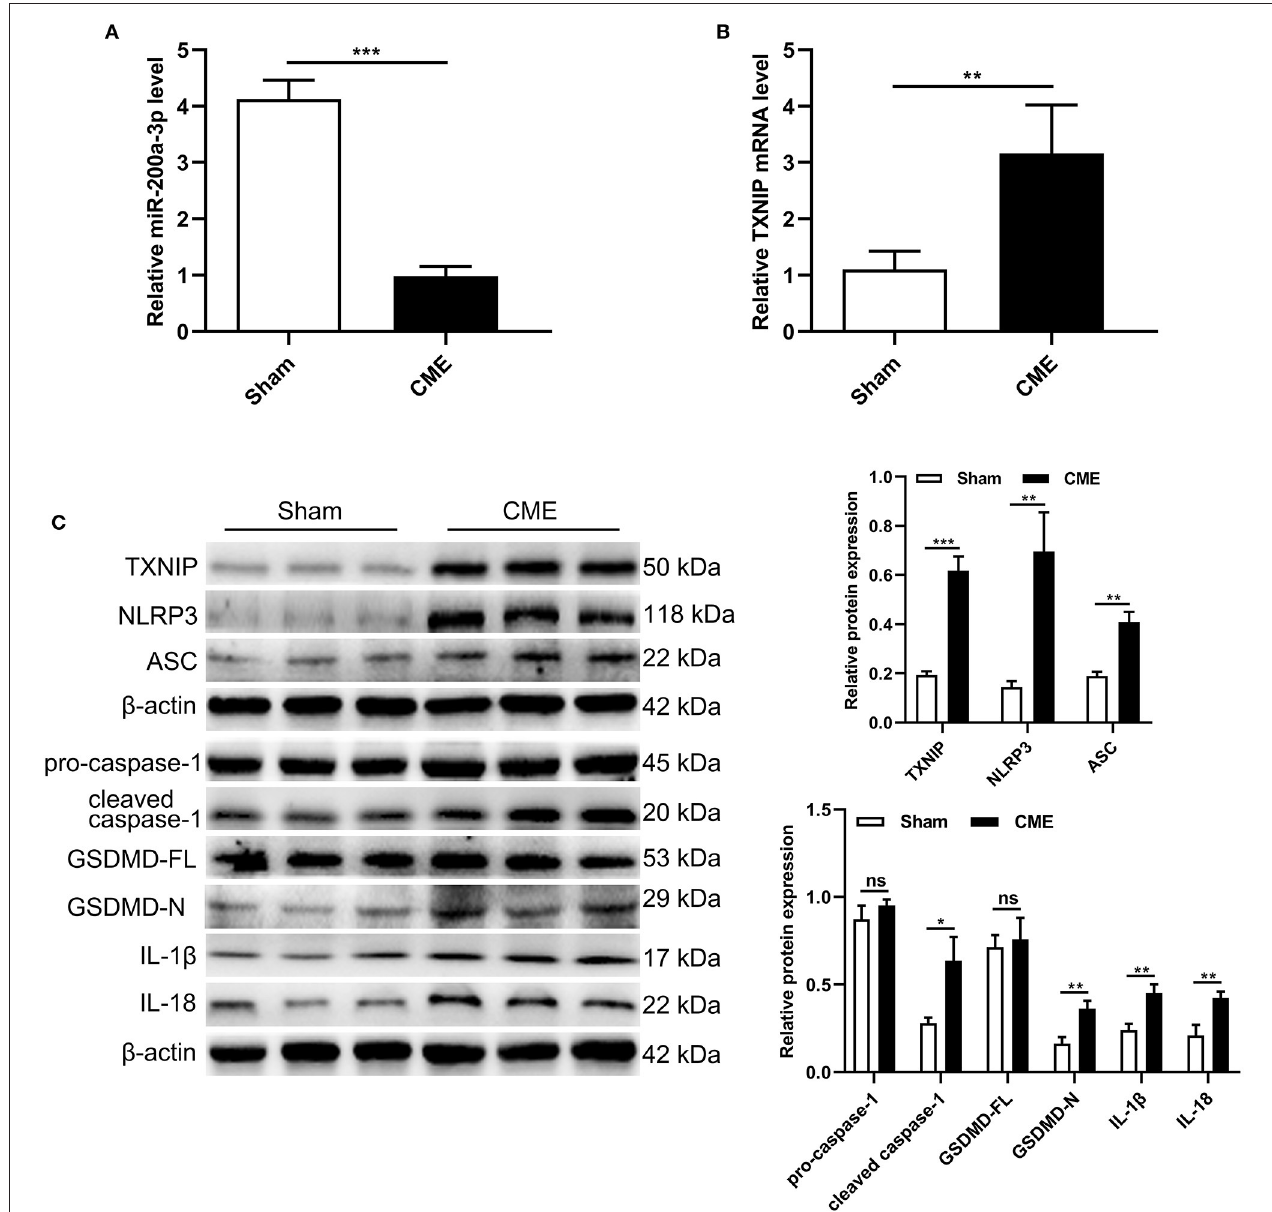
FIGURE 2 | CME induces miR-200a-3p downregulation and pyroptosis in rat myocardial tissues. (A) Relative miR-200a-3p expression level was assessed via qRT-PCR ( n = 6 per group). (B) Relative TXNIP mRNA expression level was assessed via qRT-PCR ( n = 5 per group). (C) Expression levels of proteins related to cardiomyocyte pyroptosis ( n = 3 per group). The data are presented as the mean ± standard deviation (SD). * P < 0.05, ** P < 0.01, *** P < 0.001, ns, not significant. CME, coronary